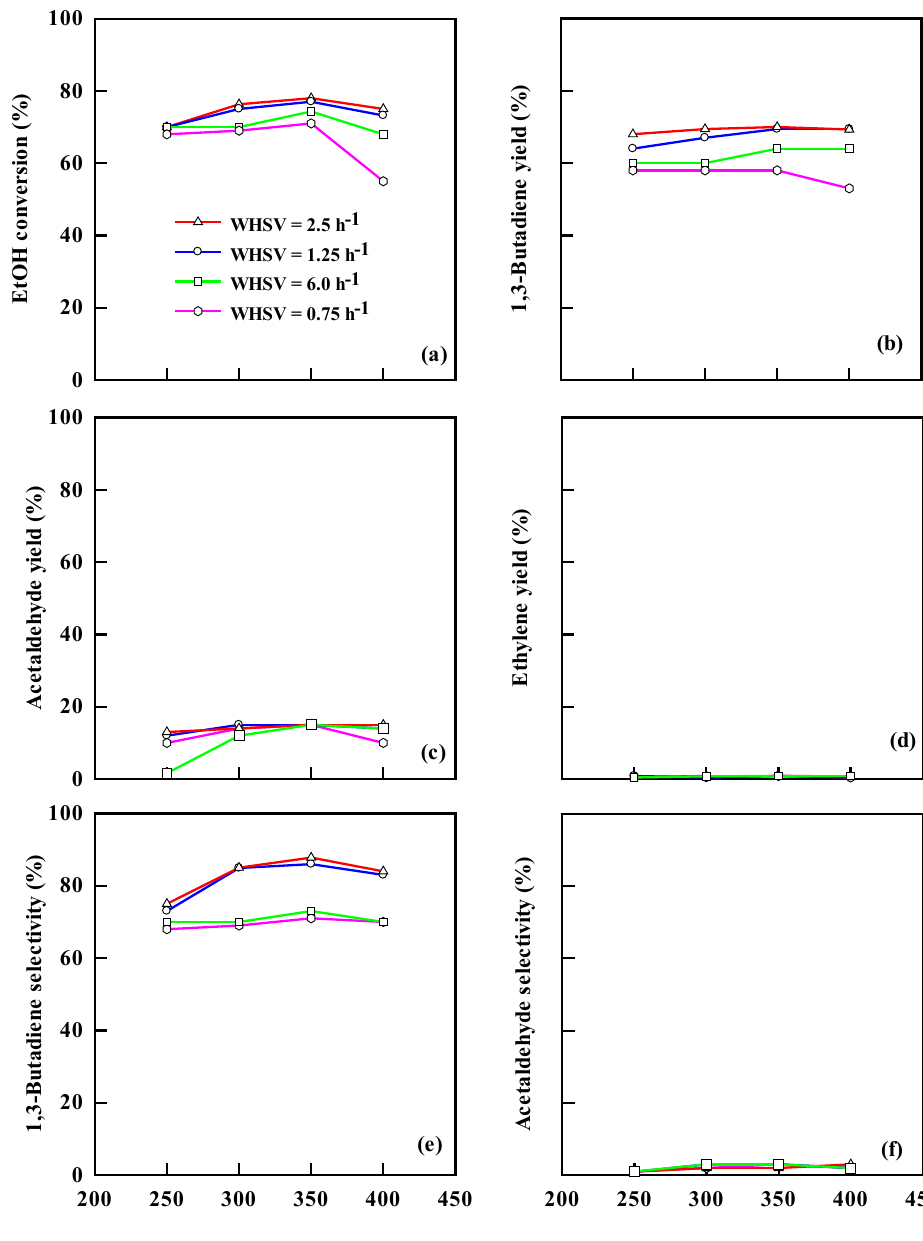
Figure 9. Plot of the Ash:MgO/ZrO 2 (1:1:1) catalyst ethanol conversion ( a ), yield ( b ) and selectivity ( e ) of 1,3-butadiene, yield ( c ) and selectively ( f ) of acetaldehyde, and ethylene yield ( d ) at different reaction temperatures and WHSV. Catalyst: 0.4 g, WHSV = 0.75–6.0 h −1 , N 2 : 30 mL/min. At 350 °C, the selectivity of 1,3-butadiene was 90.8% at 2.5 h −1 . The selectivity of 1,3- butadiene at 2.5 h −1 as temperature increased was 70% (250 °C), 83.2% (300 °C), 90.8% (350 °C), and 80% (400 °C). This activity was in accordance with the studies of Lewandowski et al., which indicate that the Zr addition increases 1,3-butadiene selectivity. Hence, the